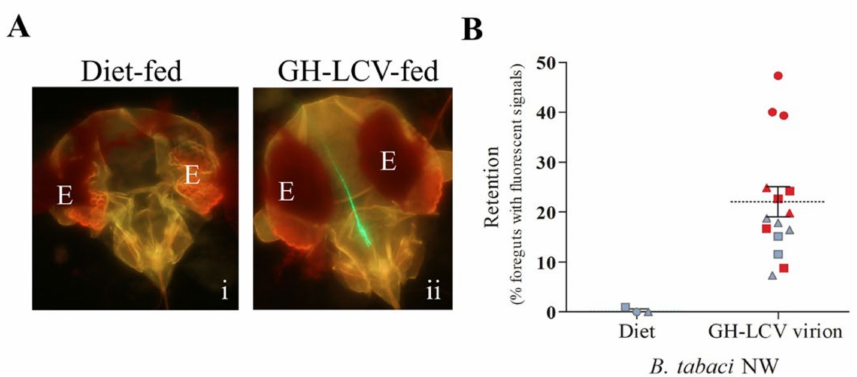
Figure 2. Foregut retention and transmission of purified GH-LCV virions by B. tabaci NW vectors. GH-LCV virions were purified from C. murale plants using an extraction buffer with 2% or 4% Triton™ X (TX)-100. Whiteflies allowed acquisition accessed feeding on an artificial diet containing GH-LCV virions, or an artificial diet alone, were used in VRT assays. ( A ) Representative images of the dissected heads of whiteflies that fed on artificial diet alone ( i ) or artificial diet containing purified GH-LCV virions ( ii ). The eye of the whitefly is labeled E in each image; ( B ) the foregut retention and transmission results of three repeated experiments for whiteflies fed on purified GH-LCV virions or diet control. Each data point represents the percentage of foreguts with fluorescent signals for one independent cage of whiteflies (i.e., one technical replicate of approximately 100 foreguts). The three symbols (circle, triangle, or square) represent each of the three repeated experiments, i.e., circle and triangle (Experiments 1 and 2, respectively, 2% ( v / v ) TX-100) and square (Experiment 3, 4% ( v / v ) TX-100). Technical replicates within an experiment share the same symbol. The mean (dashed line) and standard error (solid line) (22.02% ± 3.02%) are shown. Transmission results are presented by color symbols, indicating that the target plants were infected (red) or not infected (gray) by